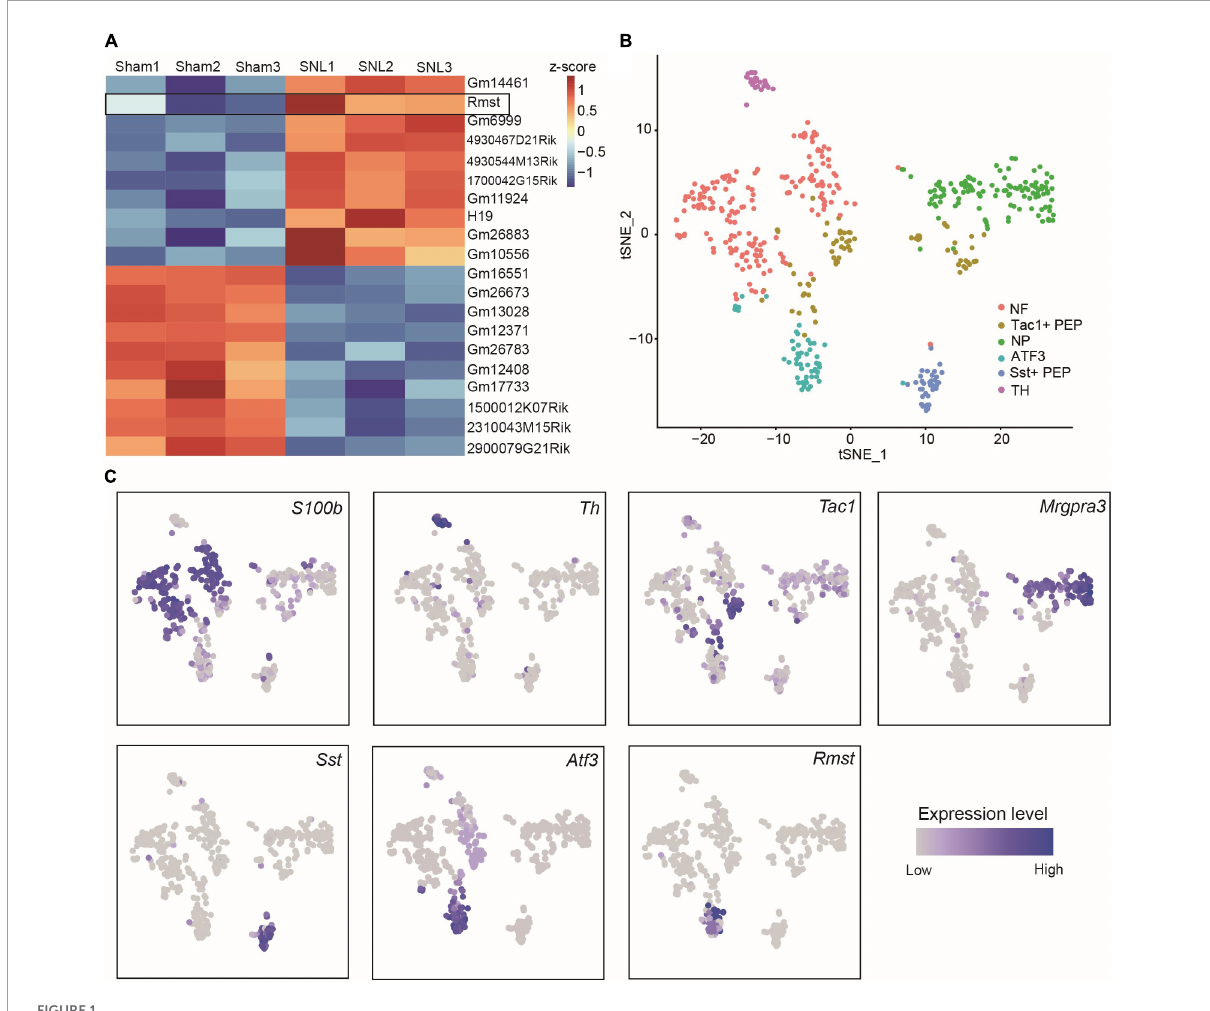
FIGURE1 Rhabdomyosarcoma 2-associated transcript ( Rmst ) was specifically expressed in Atf3 + injured neurons. (A) The 10 most up- and downregulated lncRNAs in L4 DRGs after SNL model. The heatmap was created using Z-score values obtained from RNA-seq dataset. (B) TSNE plot of all cells from DRGs after nerve injury. Each dot was color-coded and annotated by neural subtypes. NF: neurofilament, NP: non-peptidergic neurons, TH : tyrosine hydroxylase, PEP: peptidergic neurons. (C) TSNE plots showing scRNA-seq data, colored by gene expression level, showing S100b, Th, Tac1, Mrgpra3, Sst, Atf3 , and Rmst expression.